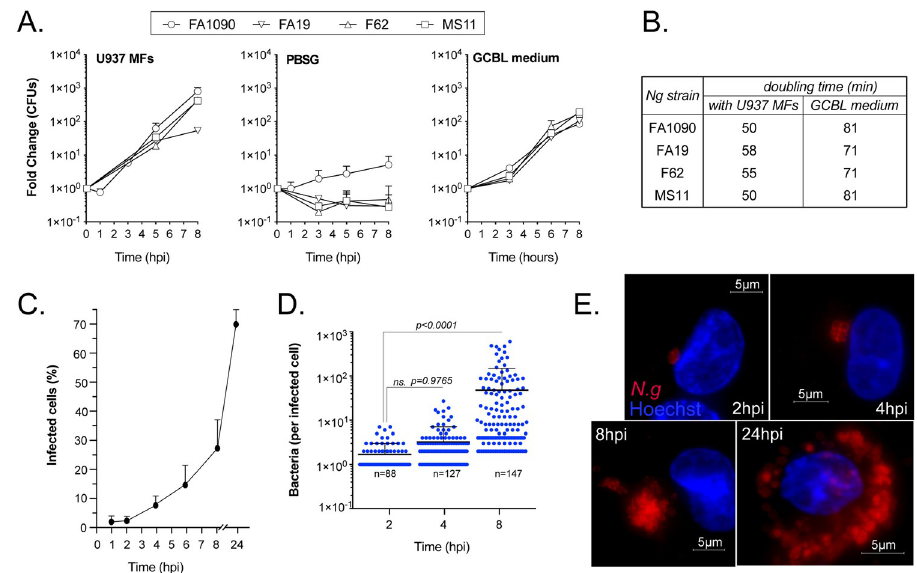
Fig 1. N . gonorrhoeae associates and replicates with human macrophages. (A) Growth of different N . g strains cultured in the presence/absence of differentiated U937 human macrophages (U937 MFs) at MOI = 0.1 or in axenic rich liquid culture media GCBL. (B) Growth rate of gonococcal strains when cultured with U937 MFs or in GCBL media calculated from recovered CFUs counts. (C-E) Microscopy analysis of gonococcal growth kinetics of N.g FA1090 with U937 MFs at MOI = 0.1 was performed on images from fixed samples at different time points. The percentage of infected macrophages (C) and the number of bacteria per cell (D) are shown. (D) The number of bacteria in each gonococcal colony were determined by mathematical conversion of 3D microscopy volume measurements. (E) Representative micrographs of N.g FA1090 infected U937 MFs at the indicated time-points. (A-E) Representative experiments from two (B) or at least three (A, C-E) biological replicates are included. (A and C) Mean of technical replicates ± SD are shown. (D) Each data point represents a single macrophage; Means ± SD are shown; one-way ANOVA analysis, not significant